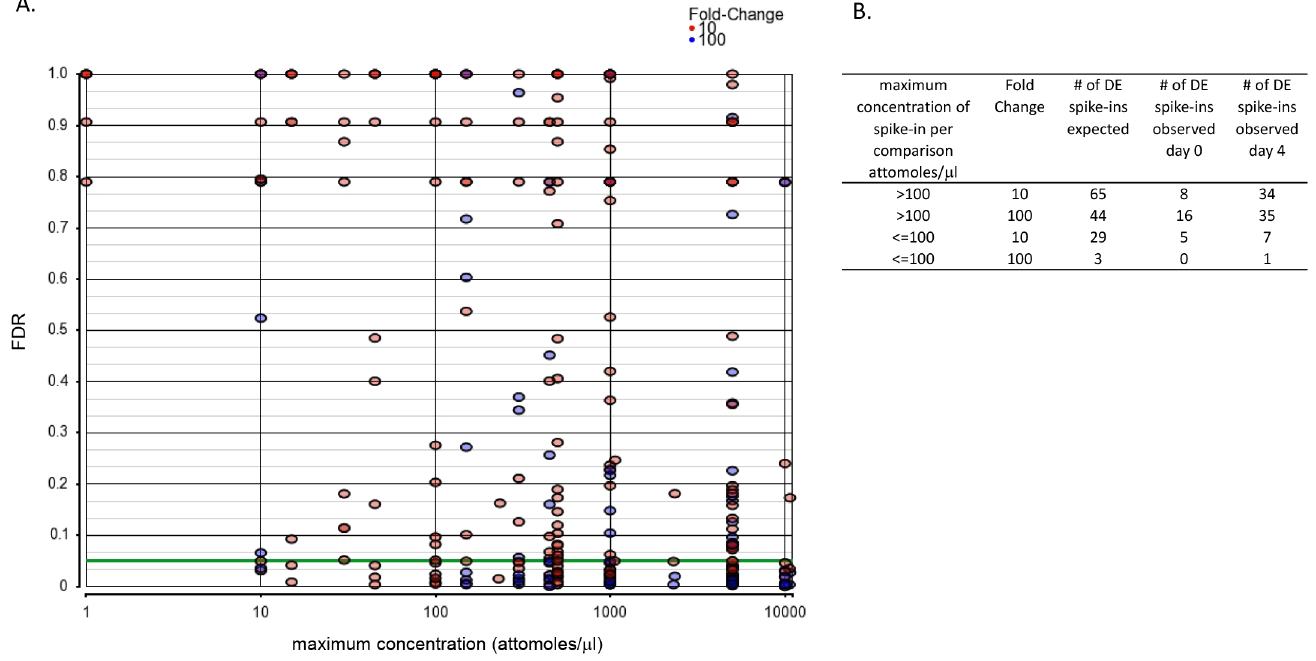
Fig 6. The relationship between the spike-in concentration and differential expression detection capacities. A scatter plot displaying association between spike-in concentrations and the ability to detect differential expression. Shown are the Partek analysis of day 0 and day 4 samples for the three mixes (1 – 3). X axis: the maximum spike-in concentration within the pairwise comparison. The color intensity is proportional to the number of points at each coordinate. The green line indicates the FDR < = 0.05